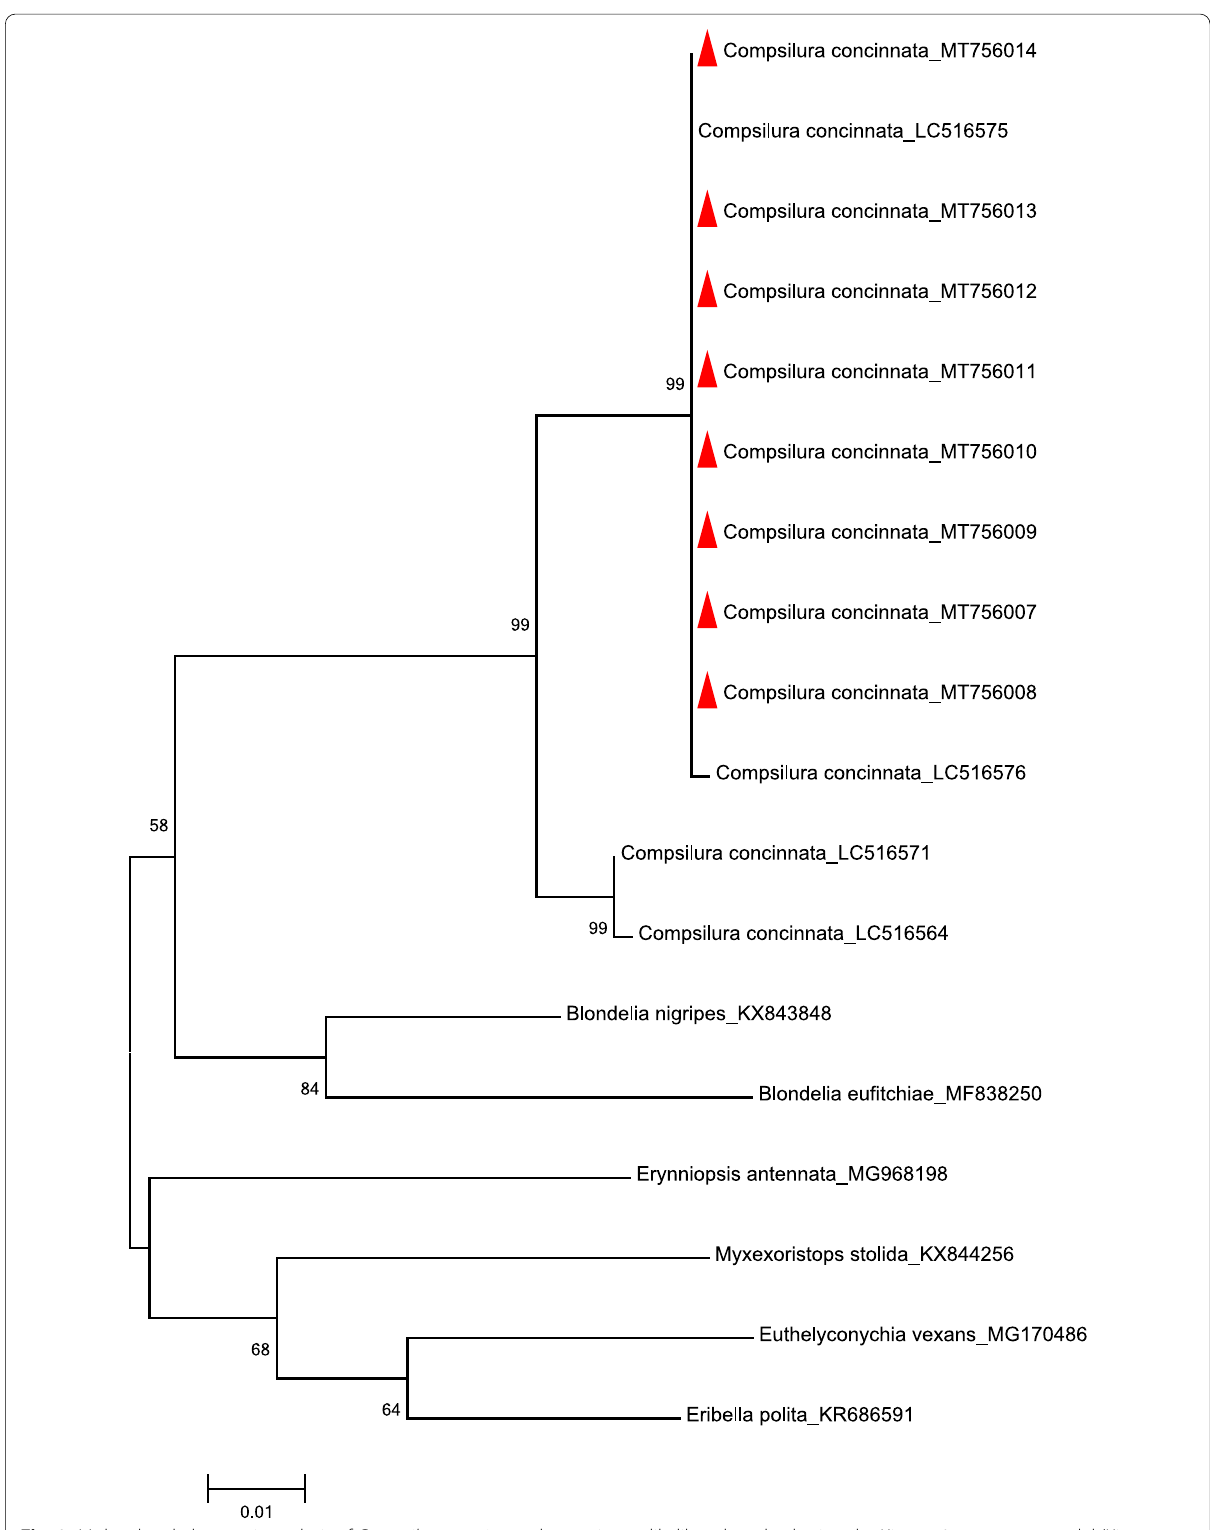
Fig. 2 Molecular phylogenetic analysis of Compsilura concinnata by maximum likelihood method using the Kimura 2‑parameter model (Kimura